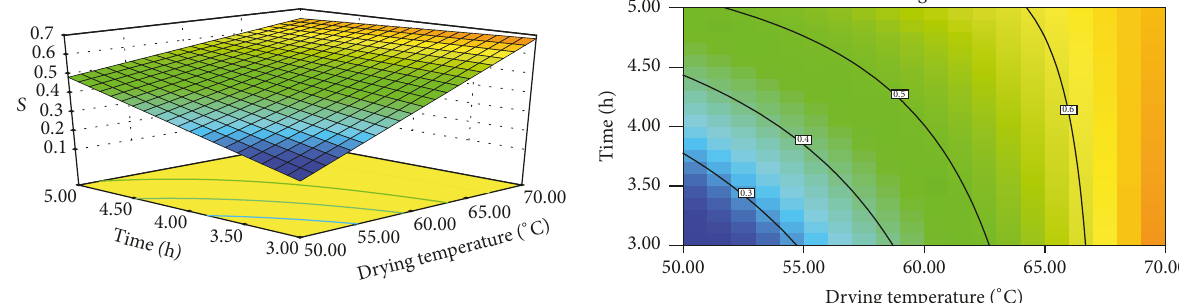
Figure 7: 3D response surface and contour plots for the effect of drying temperature and time on synthetic evaluation index ( 𝑆 ) of SLS.